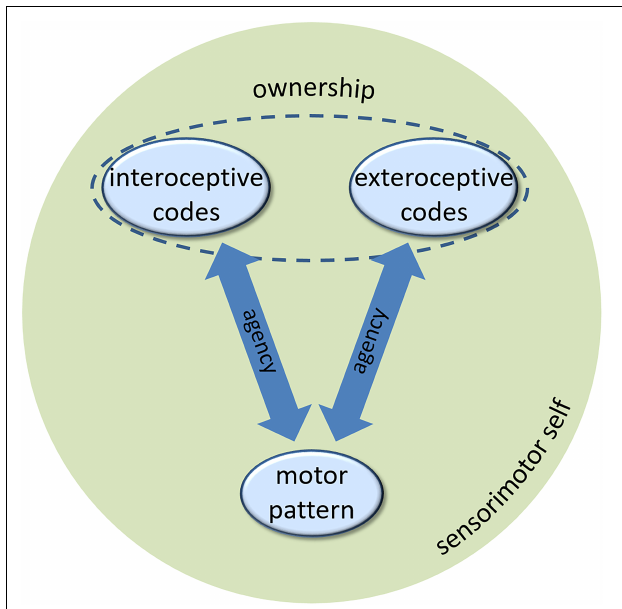
FIGURE 1 | The role of interoceptive and exteroceptive codes in generating the sense of agency and the sense of ownership of a minimal sensorimotor self (see text for